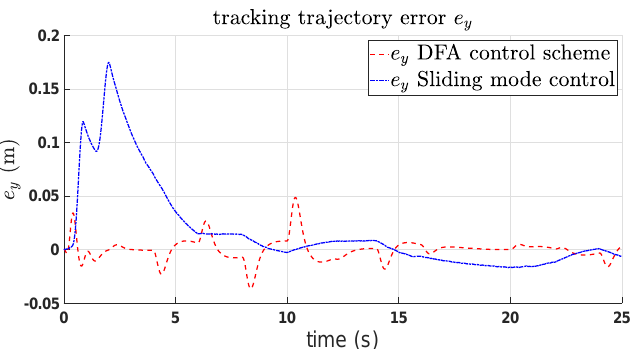
Figure 9. Tracking error behavior of e y with the proposed controller and with the sliding mode control.